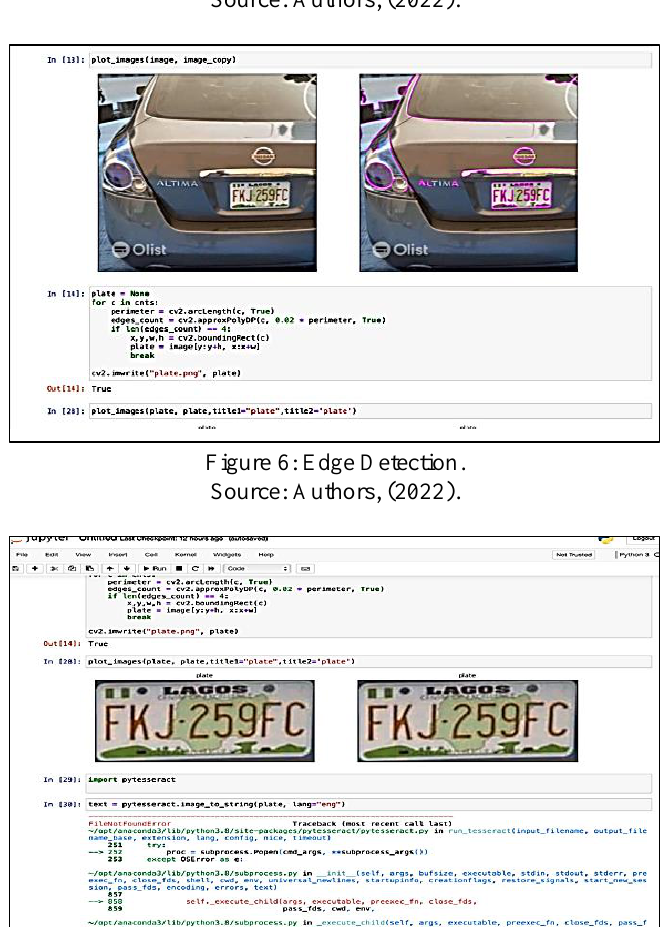
Figure 7: License Plate